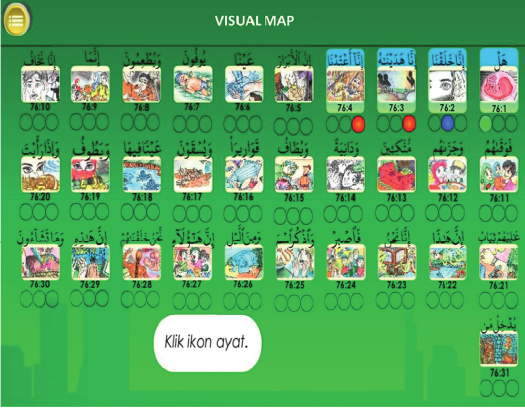
Figure 7: Visual map